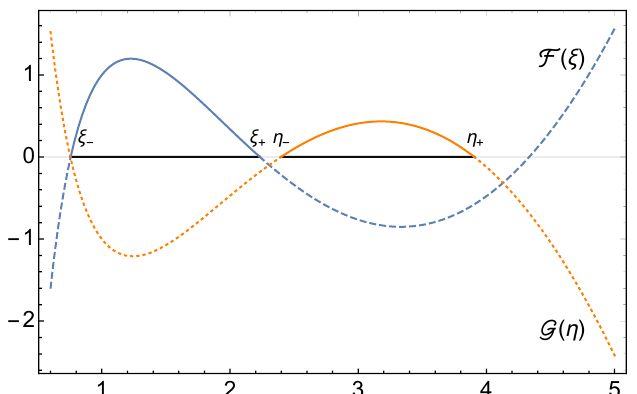
Figure 1 . Plot of F ( (cid:24) ) and G ( (cid:17) ) for a = (cid:0) 1 ; b = 19 ; c = 16 ; C = (cid:0) 1 and D = 1. The domain of F is given by [ (cid:24) (cid:0) ; (cid:24) + ] and the domain of G by [ (cid:17) (cid:0) ; (cid:17) + ], this is drawn using the solid line. Outside of their domains F is given by the dashed blue line and G by the dotted orange